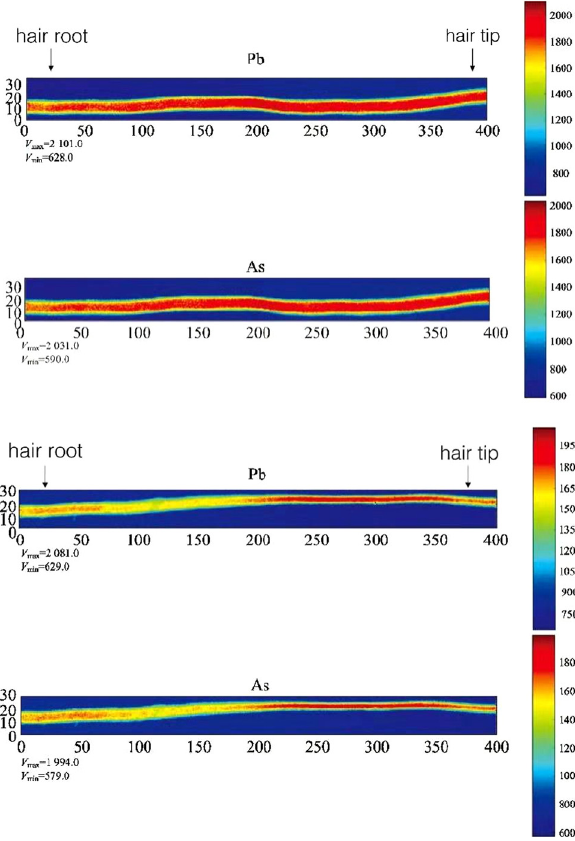
Figure 3: Micro - XRF distribution map of Pb and As in a single